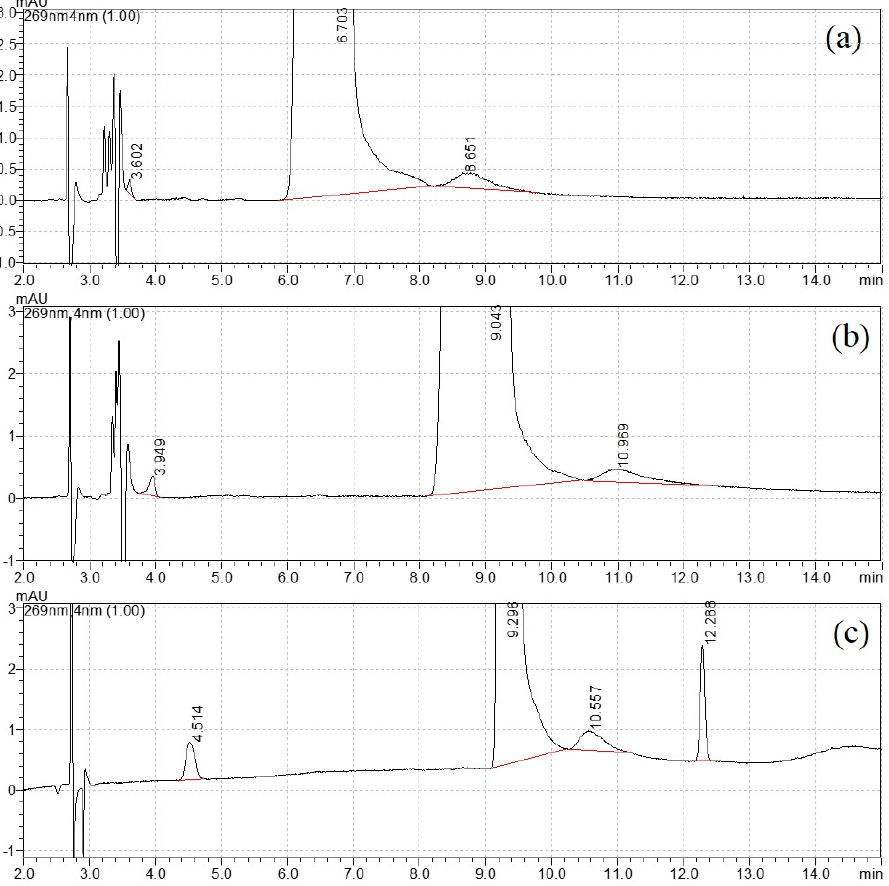
Figure 1. Mobile phase optimization: ( a ) 20% methanol, ( b ) 15% methanol and ( c ) gradient elution.